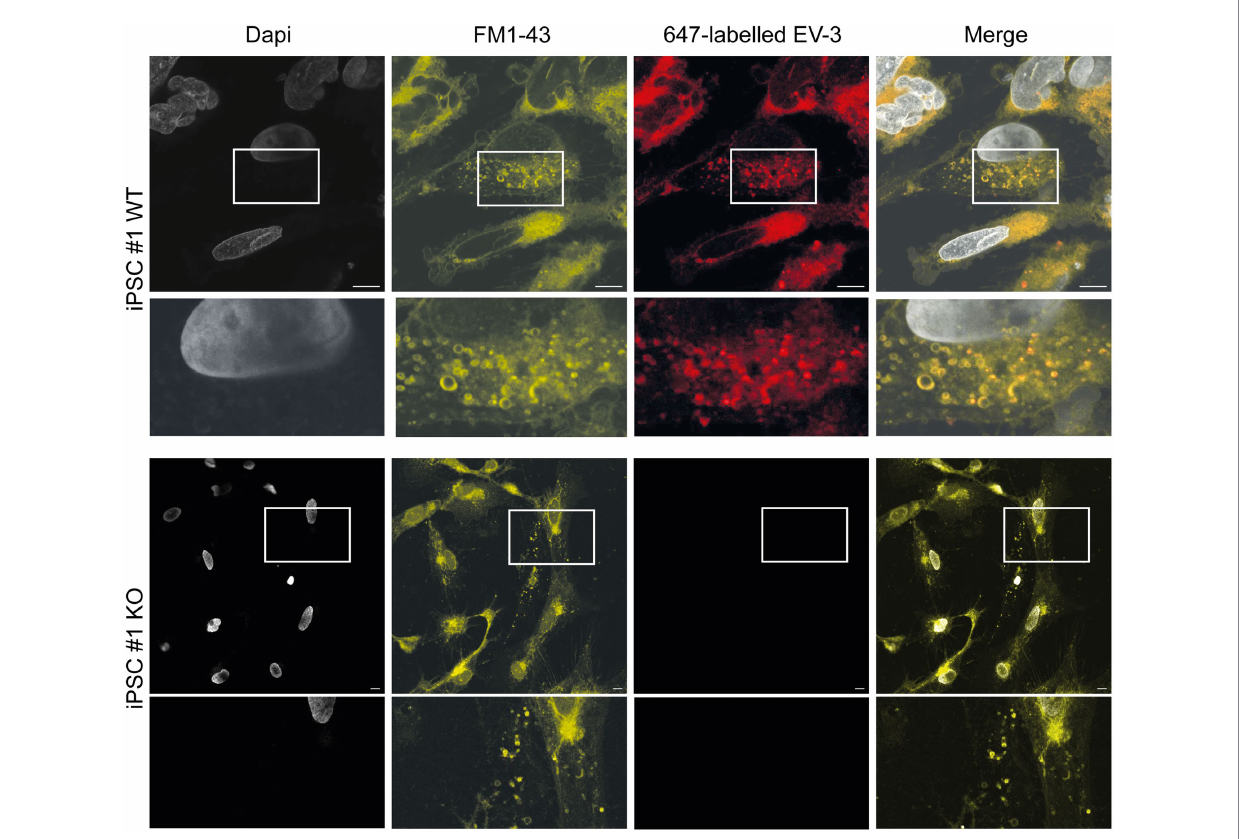
FIGURE 5 EV-3 induces endocytosis in iPSC-derived neurons. FM1-43 was used as membrane marker to visualize endocytosed vesicles. 647-labeled EV-3 was co-applied with membrane marker to visualize intracellular co-localization of EV-3 and vesicles. Top row : Exemplary image of iPSC#1 WT derived neurons, Bottom row : Neuron-like cells derived from iPSC#1 KO. Boxes depict enlarged areas displayed below the corresponding panels. Scale bars 10 μ